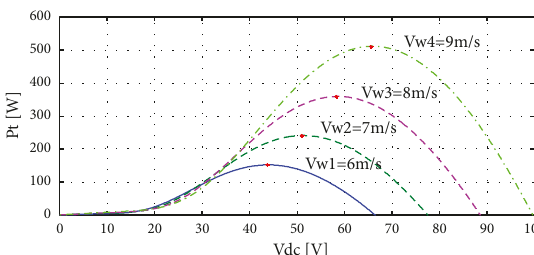
Figure 2: Generated power curve in function of the DC rectified